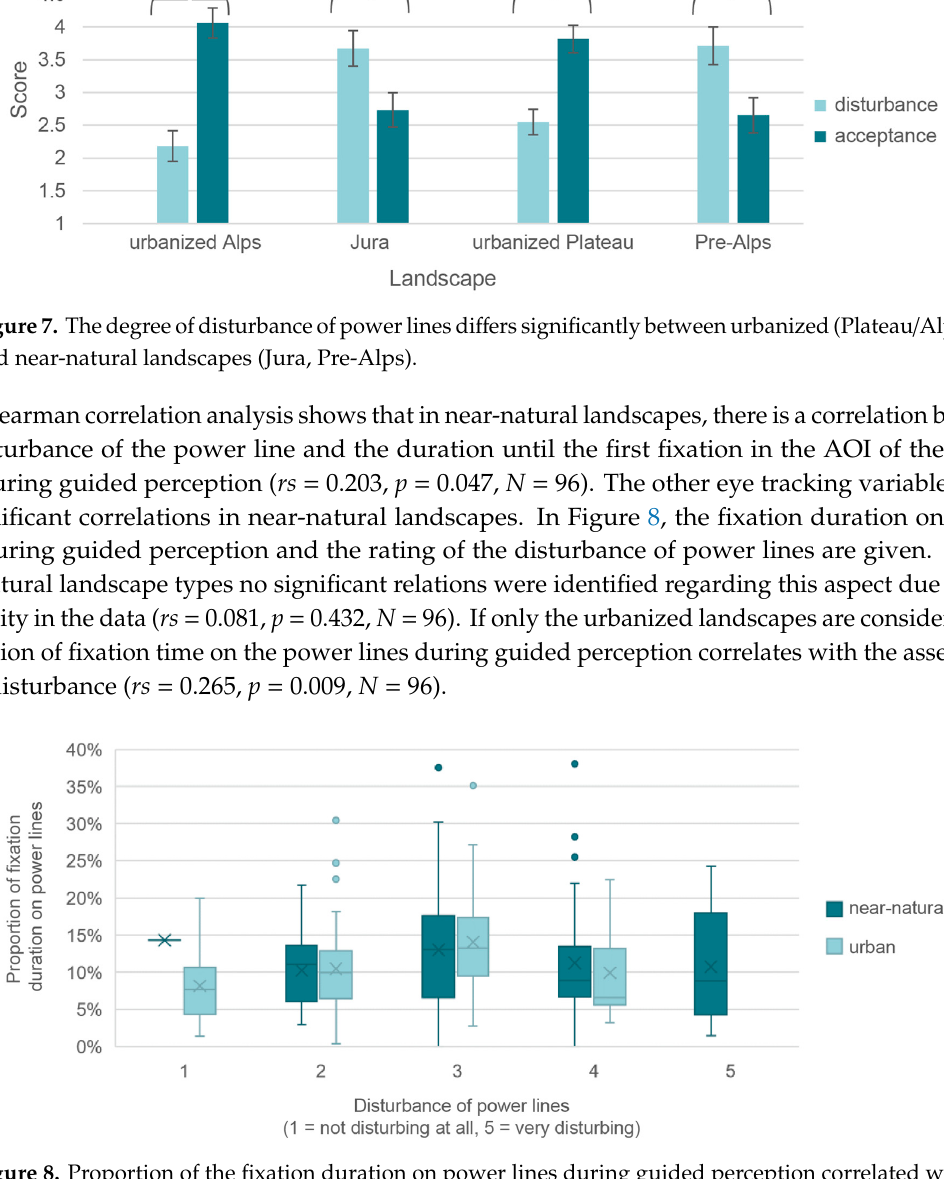
Figure 8. Proportion of the fixation duration on power lines during guided perception correlated with the rating of the disturbance of power lines for near-natural and urban landscape types.